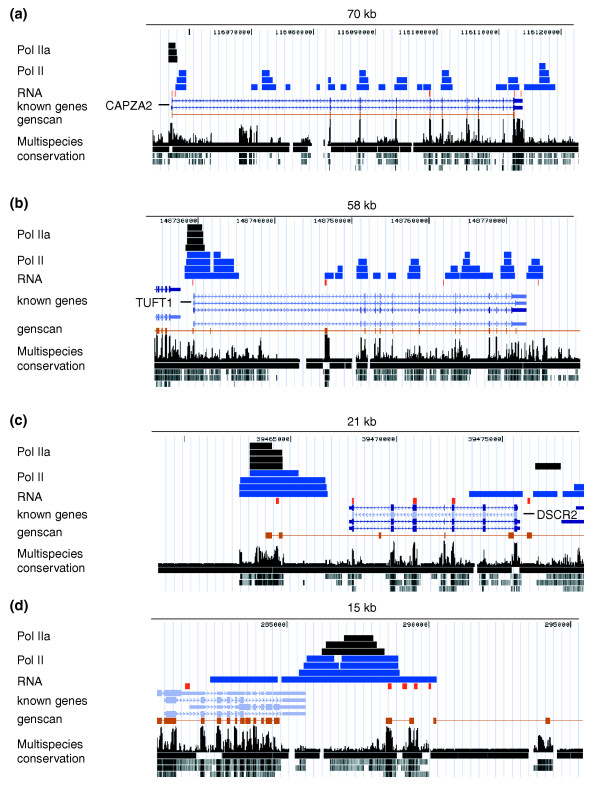
PolII enrichment is not always within annotated gene boundaries. Views are from the UCSC Genome Browser genome version HG16. PolIIa is in black and PolII is in blue with four rows for each, representing the data at different p-values: p < 10-5, p < 10-4, p < 10-3, and p < 10-2 from top to bottom. RNA signal in red. (a, b) PolII extending beyond the 3' end of the annotated gene. (c, d) PolII signal in putative intergenic regions with observed RNA signal also observed in the vicinity; (d) covers chromosome 11, positions 285,000-290,000. These regions are conserved and are also near predicted genscan exons. These novel sites not in the gene regions were confirmed by PCR.